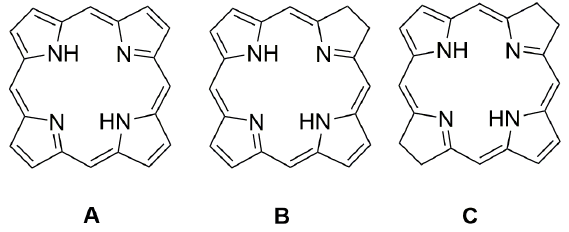
Figure 2 - Porphyrin (A), Chlorin (B) and Bacteriochlorin (C) macrocycles.